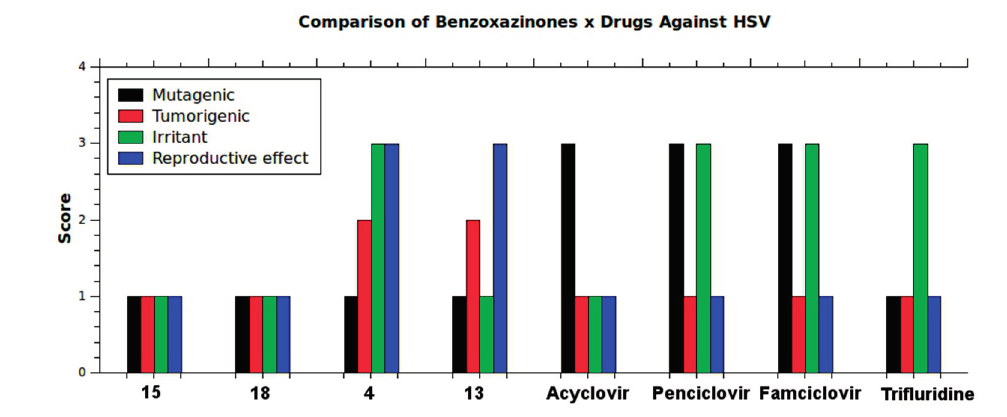
Figure 9. Results obtained from toxicity risks assessment wherein scores are given as 1 (Low Risk), 2 (Medium Risk), or 3 (High Risk). Comparison between benzoxazinones and commercial drugs against HSV shows better results for benzoxazinones 15 and 18